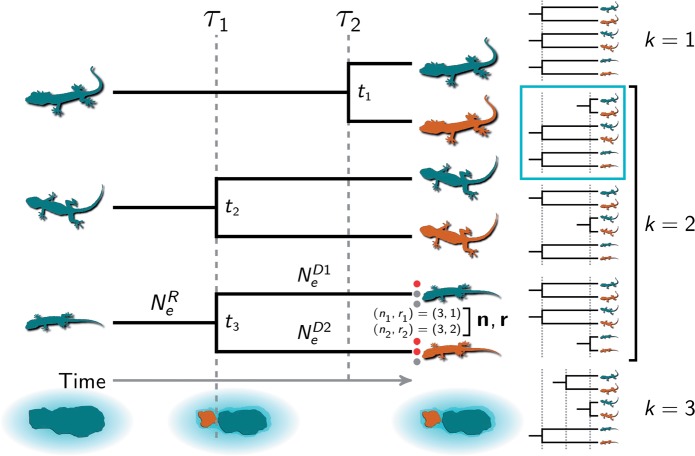
A cartoon depiction of the inference problem for three pairs of insular lizard populations. Three ancestral species of lizards co-occurred on a paleo-island that was fragmented into two islands by a rise in sea levels at τ1. The island fragmentation caused the second and third (from the top) lineages to co-diverge; the first lineage diverged later (at τ2) via over-water dispersal. The five possible divergence models are shown to the right, with the correct model indicated. The divergence-time parameters (τ1 and τ2) and the pair-specific divergence times (t1, t2, and t3) are shown. The third population pair shows the notation used in the text for the biallelic character data (\documentclass[12pt]{minimal}
\usepackage{amsmath}
\usepackage{wasysym}
\usepackage{amsfonts}
\usepackage{amssymb}
\usepackage{amsbsy}
\usepackage{upgreek}
\usepackage{mathrsfs}
\setlength{\oddsidemargin}{-69pt}
\begin{document}
}{}${\mathbf{n}}, {\mathbf{r}} = ({{n_{1}}}, {{r_{1}}}), ({{n_{2}}}, {{r_{2}}})$\end{document}) and effective sizes of the ancestral (\documentclass[12pt]{minimal}
\usepackage{amsmath}
\usepackage{wasysym}
\usepackage{amsfonts}
\usepackage{amssymb}
\usepackage{amsbsy}
\usepackage{upgreek}
\usepackage{mathrsfs}
\setlength{\oddsidemargin}{-69pt}
\begin{document}
}{}${N_{e}^{{R}}}$\end{document}) and descendant (\documentclass[12pt]{minimal}
\usepackage{amsmath}
\usepackage{wasysym}
\usepackage{amsfonts}
\usepackage{amssymb}
\usepackage{amsbsy}
\usepackage{upgreek}
\usepackage{mathrsfs}
\setlength{\oddsidemargin}{-69pt}
\begin{document}
}{}${N_{e}^{{D{1}}}}$\end{document} and \documentclass[12pt]{minimal}
\usepackage{amsmath}
\usepackage{wasysym}
\usepackage{amsfonts}
\usepackage{amssymb}
\usepackage{amsbsy}
\usepackage{upgreek}
\usepackage{mathrsfs}
\setlength{\oddsidemargin}{-69pt}
\begin{document}
}{}${N_{e}^{{D{2}}}}$\end{document}) populations. The lizard silhouette for the middle pair is from pixabay.com, and the other two are from phylopic.org; all were licensed under the Creative Commons (CC0) 1.0 Universal Public Domain Dedication.